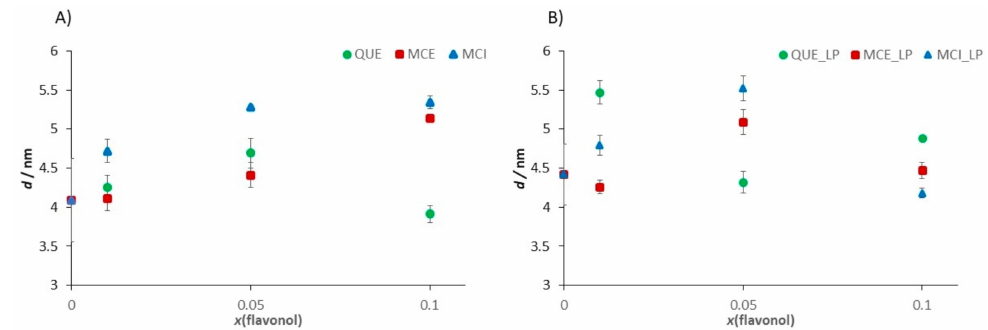
Figure 14. The change in the bilayer thickness value induced ( A ) by the insertion of the flavonols in dependence of the molar fraction of inserted flavonols and ( B ) by the induced lipid peroxidation process in the SLB as a function of the molar fraction of inserted